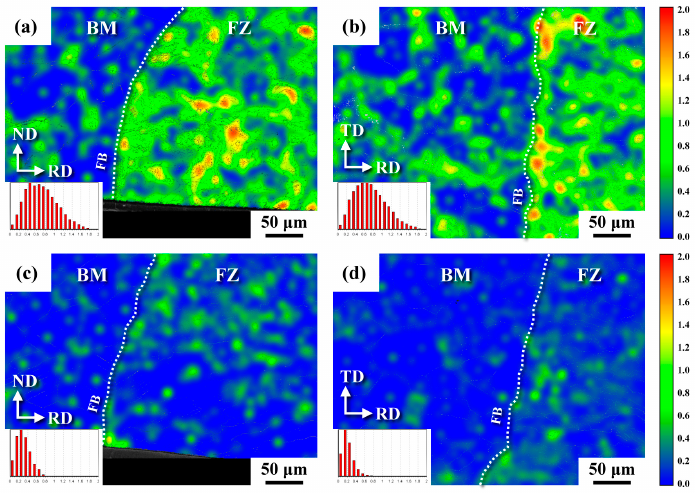
Figure 9. Strain maps around the FB of the ( a ) and ( b ) 304 weld and ( c ) and ( d ) 316 weld. ( a ) and ( c ) cross-sectional views and ( b ) and ( d ) top views.